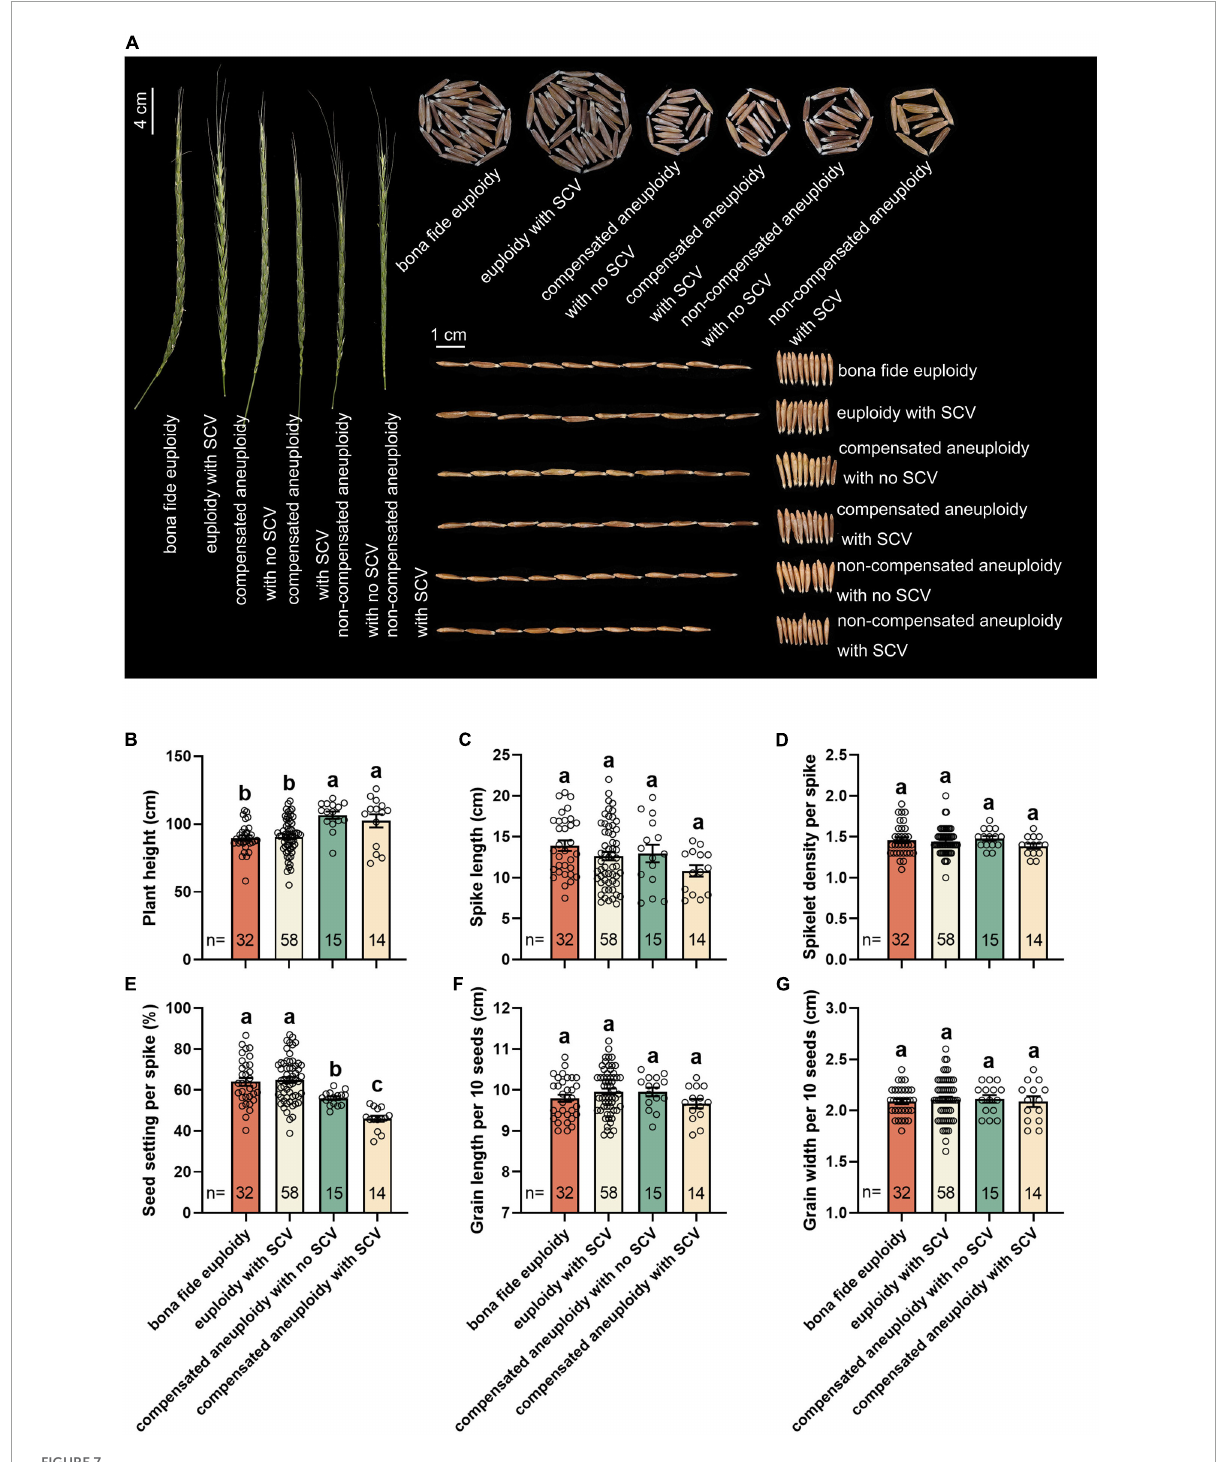
FIGURE7 Variation in phenotypic traits across the phenotypic categories. (A) Variation in spike, seed-setting/individual, seed-length and seed-width among the six karyotypic categories ( Figure 2 ). Quantification of the six phenotypic traits, plant height (B) , spike length (C) , spikelet density per spike (D) , seed setting per spike (E) , grain length per 10 seeds (F) , and grain width per 10 seeds (G) , among four karyotypic categories that each had sufficient number of plants enabling the analysis. The y -axis is mean ( ± SD). Different letters on the bars indicate significant differences based on the least significant difference (LSD) test ( P < 0.05). The numbers (n) inside the bars refer to individual numbers in each of the four karyotypic